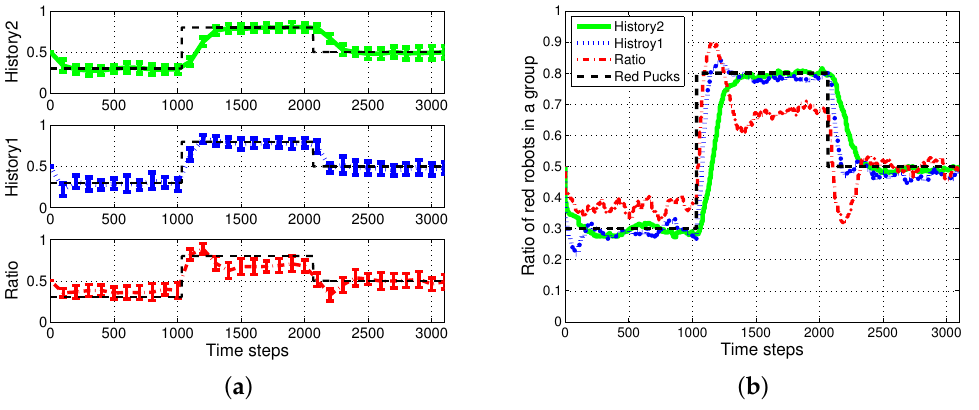
Figure 5. Ratio of robots foraging for red pucks in a group. ( a ) Individual trend of each algorithm; ( b ) overlapping trends of all algorithms.